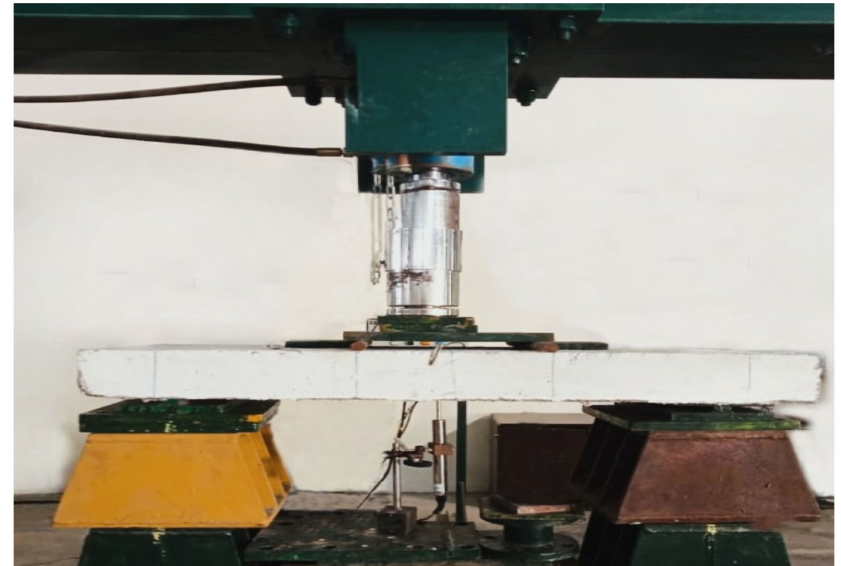
Figure 3. Testing of the slab